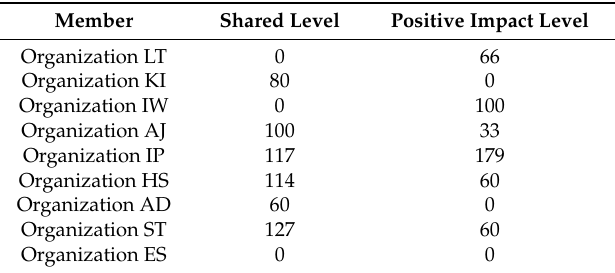
Table 8. Network Alignment Report.